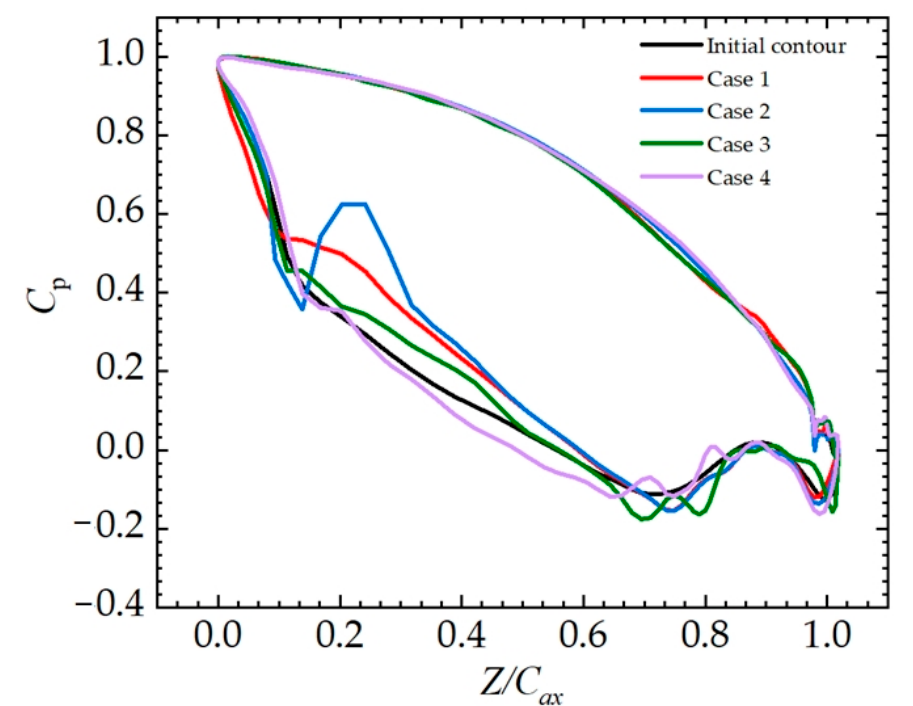
Figure 7. The coefficient distributions for static pressure.